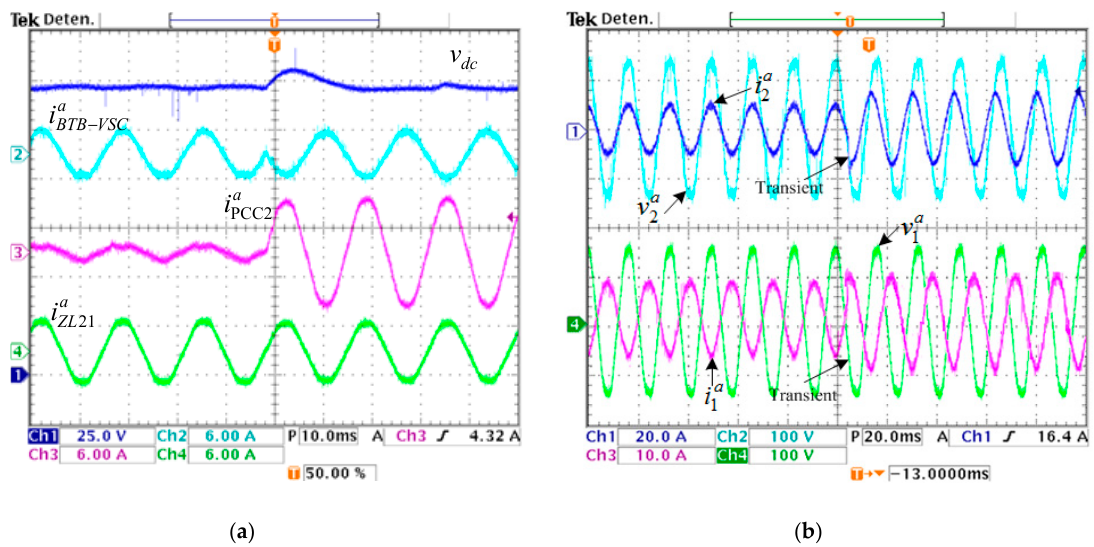
Figure 14. Test results: ( a ) Active power flow reversal. Ch1, DC bus voltage; Ch2, current injected with the BTB-VSC at the PCC2; Ch3, Current measured at the PCC2; Ch4, current for the load Z L 21 . Vertical sensitivities: Ch1, 25 V/div; Ch2–Ch4, 6 A/div. Horizontal sensitivity: 10 ms/div. ( b ) Active power regulation and reactive power compensation. Ch1, current measured at the PCC2; Ch2, voltage measured at the PCC2; Ch3, current measured at the PCC1; Ch4, voltage measured at the PCC1. Vertical sensitivities: Ch1, 20 A/div; Ch3, 10A/div; Ch2 and Ch4, 100 V/div. Horizontal sensitivity: 20 ms/div.